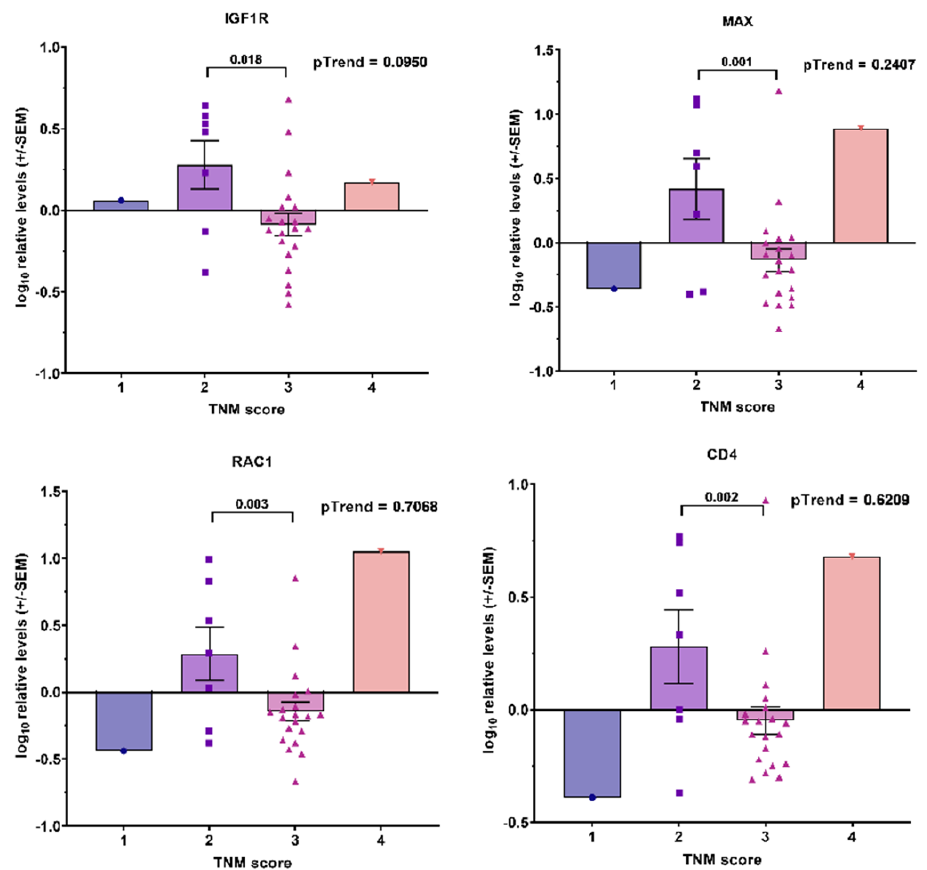
Figure A3. Associations between transcripts’ expression in blood-derived mRNA and TNM score in ADT − cohort with no overall significance in trend, but with statistical significance for TNM2/TNM3 comparison. Bar graphs showing − log10 relative expression levels of gene transcripts in different TNM score groups. p values are indicated after linear test for trend following ANOVA or after unpaired t -test between two groups (TNM = 2 and TNM = 3).